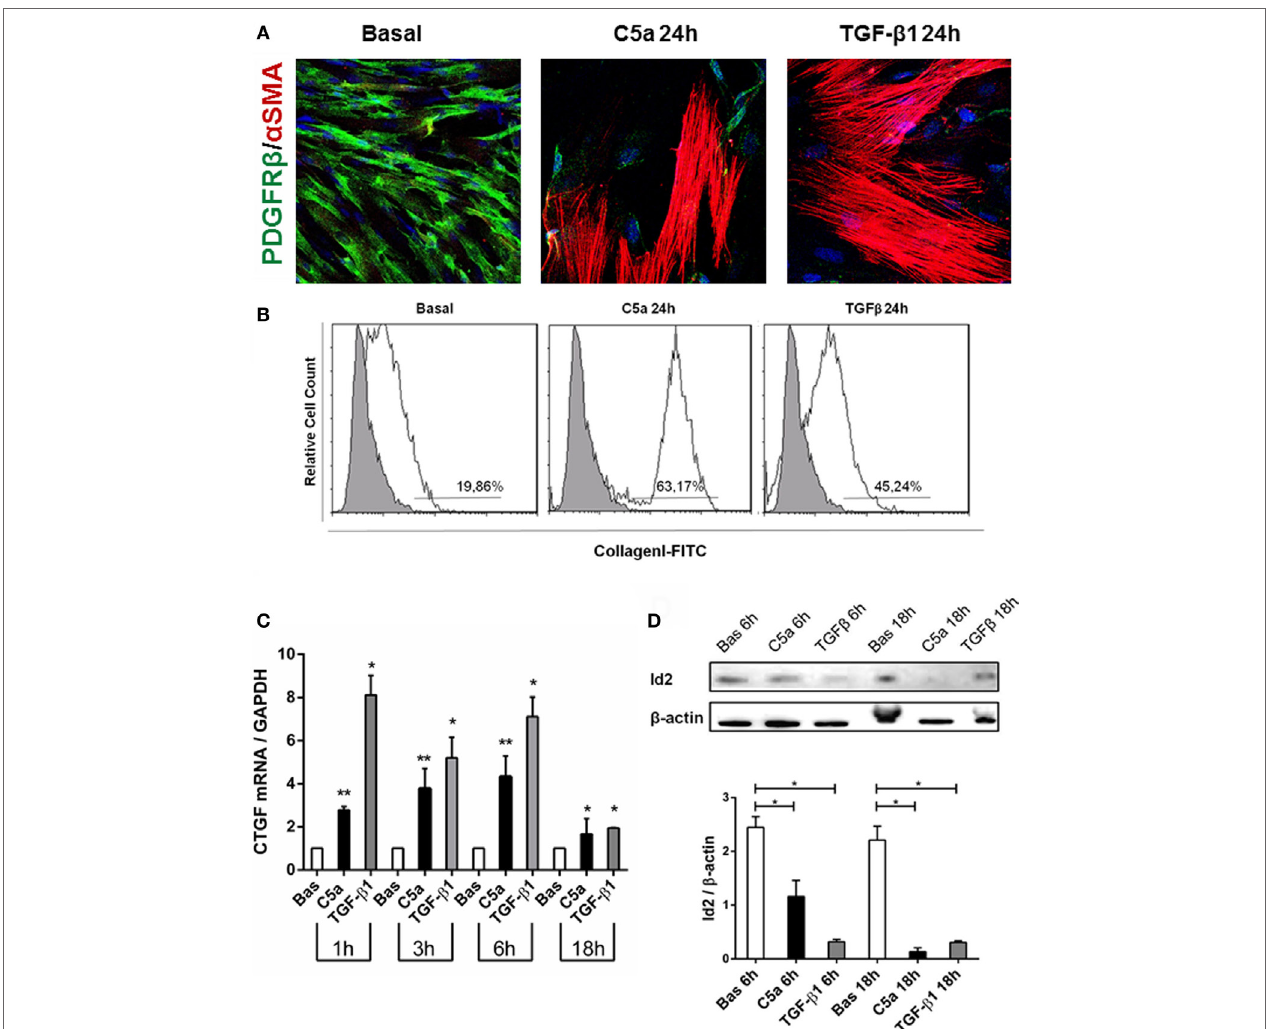
FigUre 7 | C5a induced PMT in vitro. Pericytes were incubated with C5a and TGF β 1 for 24 h. (a) Immunofluorescence showed a drastic remodeling of α SMA- stress fibers (b) FACS analysis showed increased collagen I expression in permeabilized cells, after C5a exposition. (c) mRNA expression levels of connective tissue growth factor (CTGF) (CCN2) were determined by qPCR. C5a stimulated pericytes showed a significant increase after 3 and 6 h of incubation. The fold change of CTGF expression was normalized to GAPDH. The histograms represent the mean ± SD, n = 3. (D) Western Blot showed a significant reduction of Id2 protein compared to basal condition, β -actin protein expression was used for normalization (* p < 0.05, ** p <